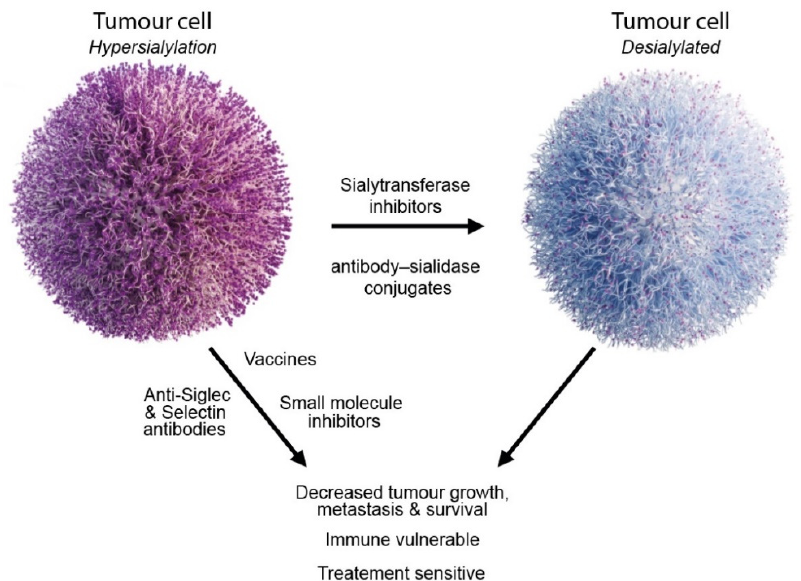
Figure 3. Strategies to target aberrant sialylation in cancer. Funding: This work was supported by Prostate Cancer UK through a Research Innovation Award (RIA16-ST2-011), Prostate Cancer Research (grant reference 6961), and The Mark Foundation for Cancer